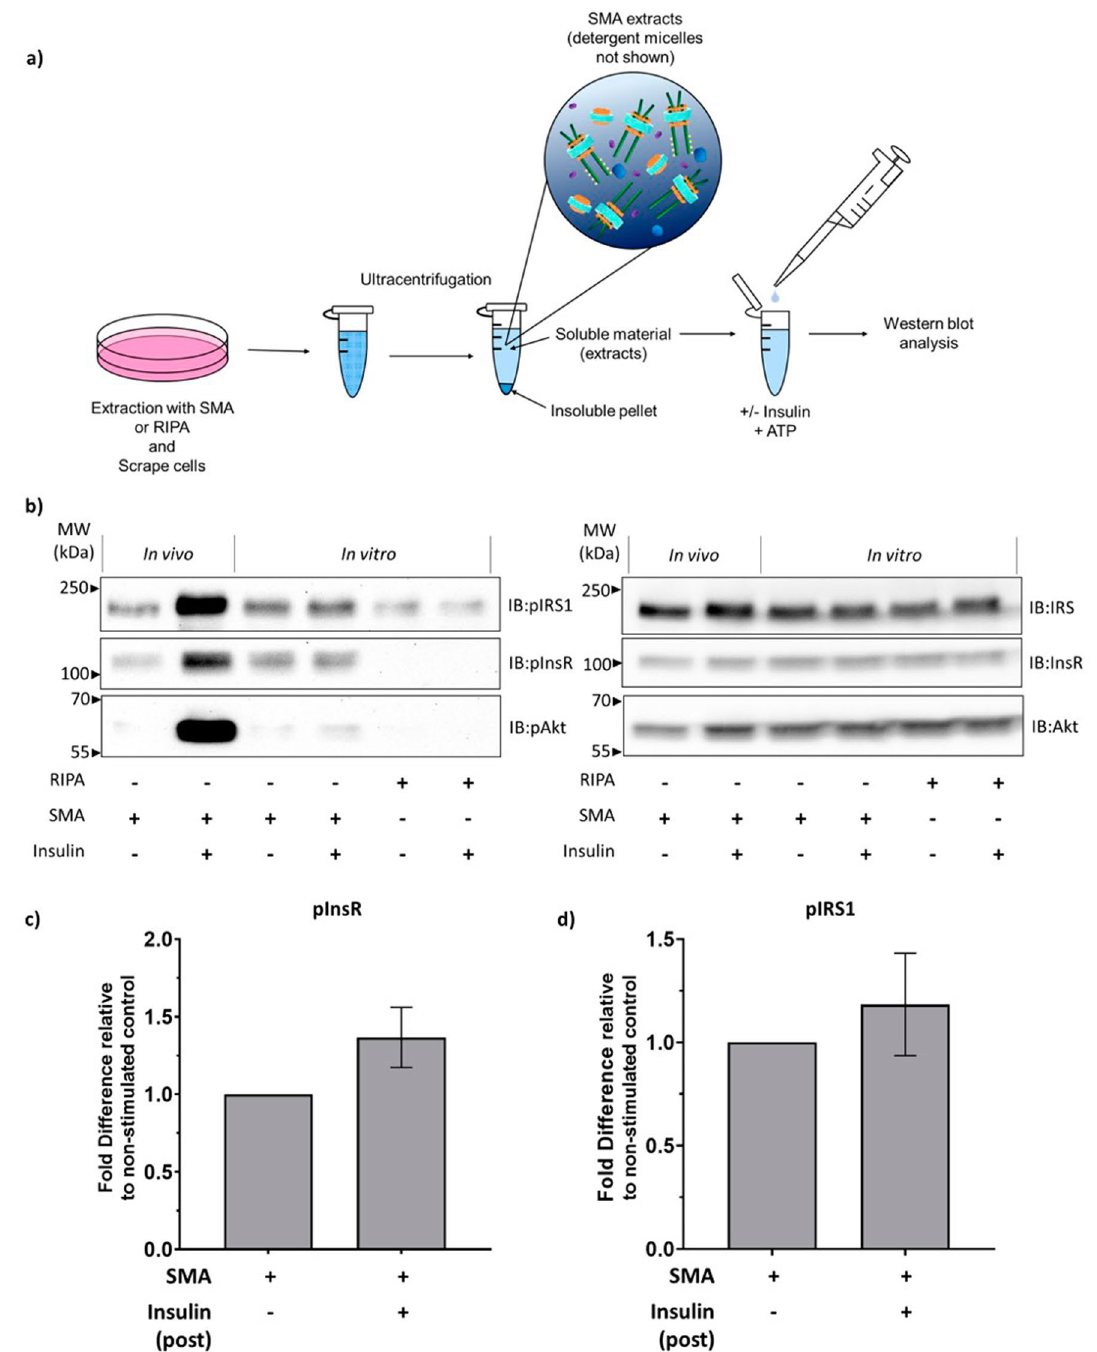
Figure 4. Analysis of in vitro activation of InsR by insulin following extraction from cells. ( a ) Schematic diagram of the experimental protocol for in vitro stimulation of SMA/RIPA extracts. Untreated cells were extracted with SMA or RIPA and insoluble material was removed by centrifugation. Extracts were treated with 100 nM insulin (in vitro) (+Insulin) or left untreated (−Insulin). ( b ) Representative immunoblots are shown with phospho-specific antibody detection (left-panel) and corresponding total protein (right panel). Extracts from cells treated with 100 nM insulin (+Insulin) or untreated (−Insulin) prior to extraction (in vivo) with SMA are also shown on the same gel for comparison. ( c ) Quantification of InsR phosphorylation levels in SMA extracts. Data are expressed as ratio of pInsR/total InsR and compared to the ratio from basal cells extracted with SMA as fold difference relative to non-stimulated control. Values are means ± SEM, n = 3. P -values were determined by paired t-test. ( d ) Quantification of IRS1 phosphorylation levels in SMA extracts Shown as ratio of pIRS1/total IRS1 and compared to the ratio from basal cells extracted with SMA as fold difference relative to non-stimulated control. Values are means ± SEM, n = 3. P -values were determined by paired